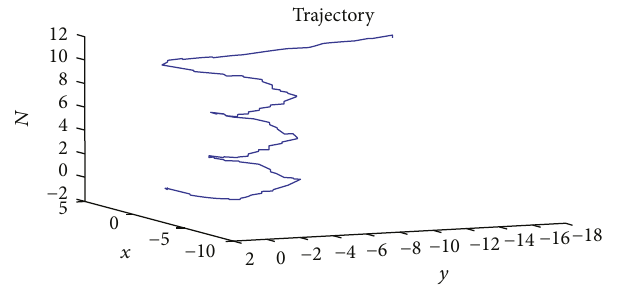
Figure 12: Results of data fusion using the IMU and Table 3: Comparison of the three groups of experiments. Experiment Actual height (m)